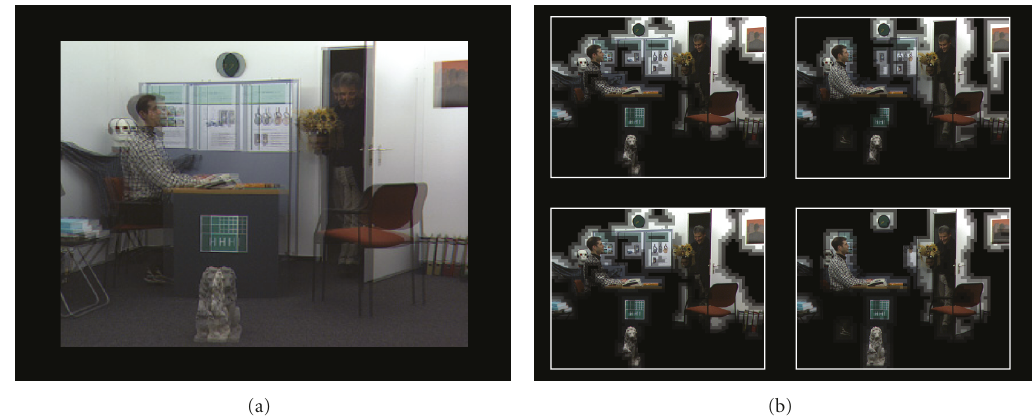
Figure 8: (a) Example of stereoscopic video (b) ROIs on monoview LCD display.